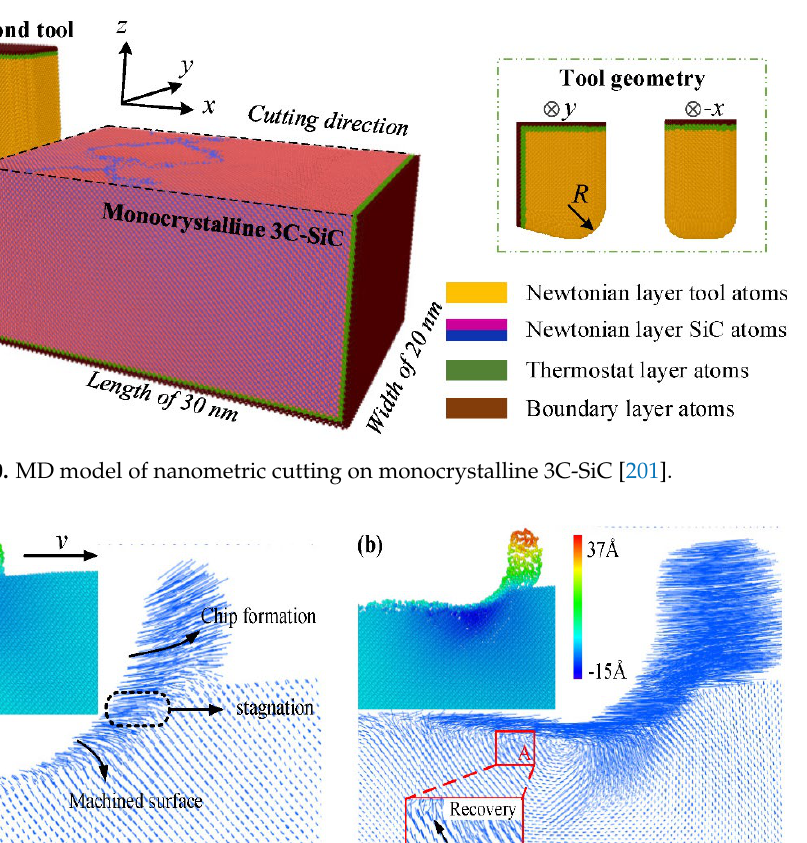
Figure 39. Comparative analysis of cutting force signals; ap = 6 Å, vw = 2 Å/ps, Az = 2 Å, f = 160 GHz ( a ) Tangential force signal ( b ) Normal force signal [200].